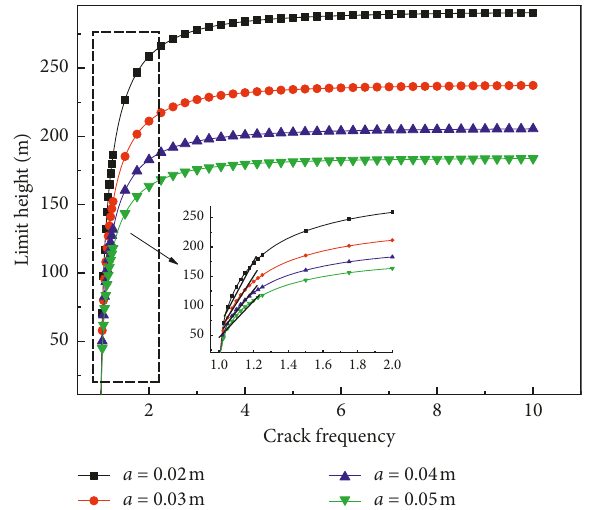
Figure 13: The limit heights of composite slope under different crack